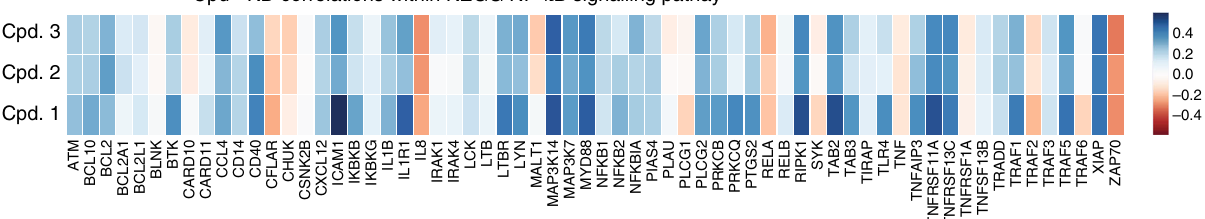
Fig. 1 Transcriptional responses to compounds correlate with knockdowns of NF- κ B pathway genes. a Schematic of the mature tumor necrosis factor (TNF) receptor 1 (TNFR1) complex, a cytoplasmic multi-protein complex that assembles following ligation of TNF to TNFR1. The color for each protein species in the complex is the average Pearson correlation between gene expression pro fi les for the species ’ genetic knockdown and the transcriptional response to compounds 2 and 3. b Correlation between transcriptomic perturbations by compounds 1, 2, and 3 and the knockdown of genes functionally involved in NF- κ B according to the KEGG PATHWAY Database. Pearson correlation color scale is shown (right). c Unbiased molecular docking predicts binding of compounds 2 (yellow) and 3 (magenta) to the TRADD-binding interface of TRAF2. Hydrogen bonds with key TRAF2 interface residues are indicated by dotted lines. Source data are provided as a Source Data fi were selected for testing: (1) BRD-K43131268, (2) BRD- K95352812, and (3) BRD-A09719808. For compounds 1, 2, and 3